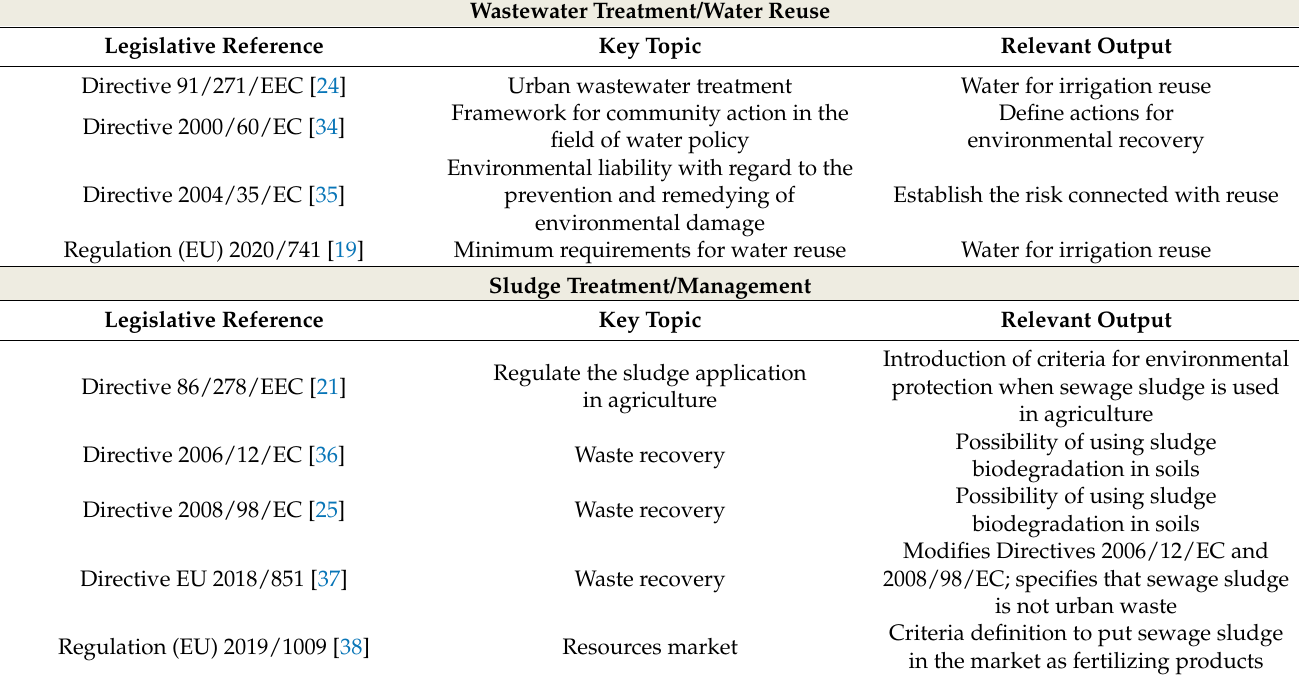
Table 1. Summary of the main European legislation in the fields of wastewater treatment/water reuse and sludge